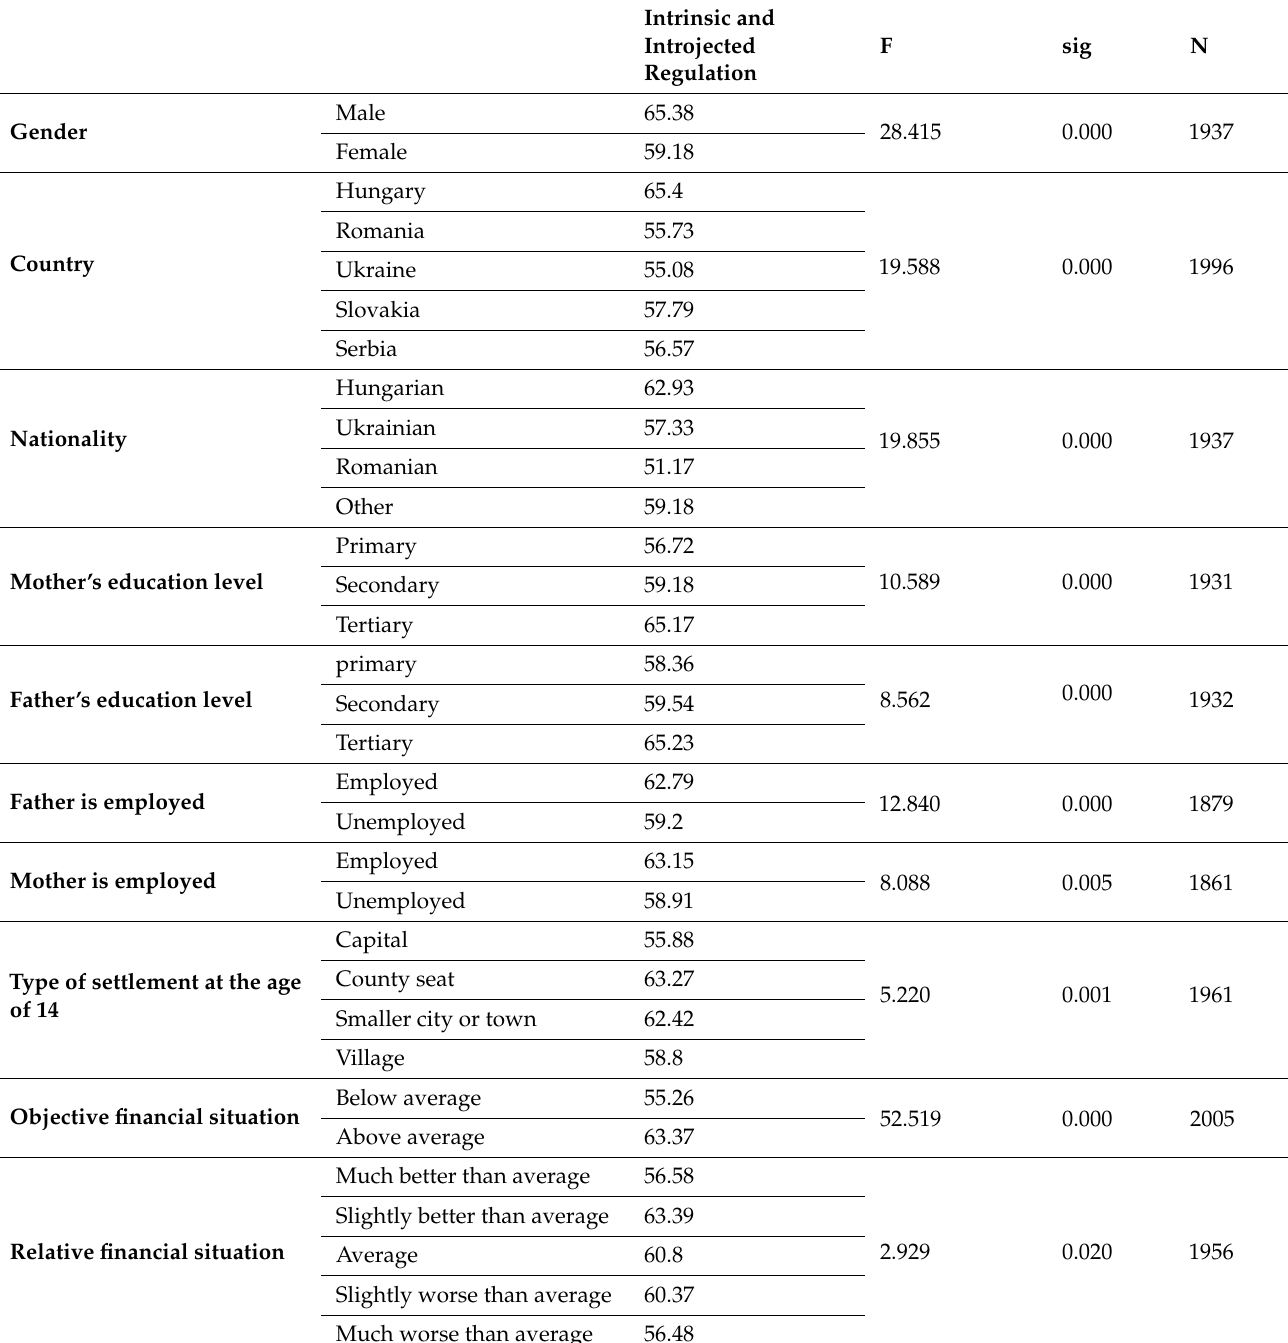
Table A4. Sociocultural and demographic background of intrinsic and identified regulation. Source: PERSIST